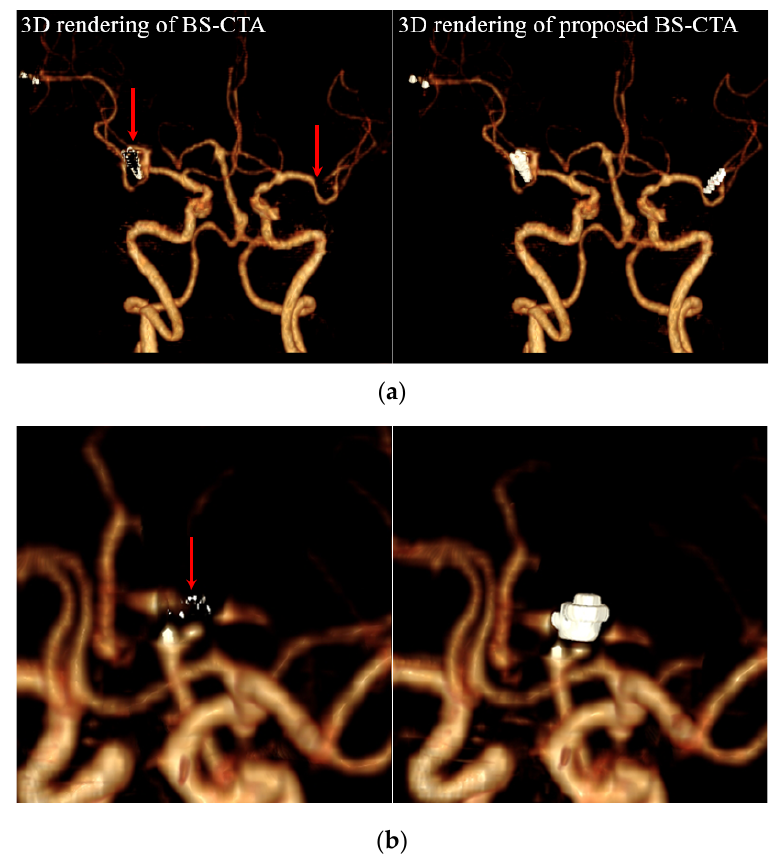
Figure 8. Results of 3D rendering based on BS-CTA and proposed BS-CTA from Figure 7. ( a ) Insertion of the two clips and ( b ) the coil components.